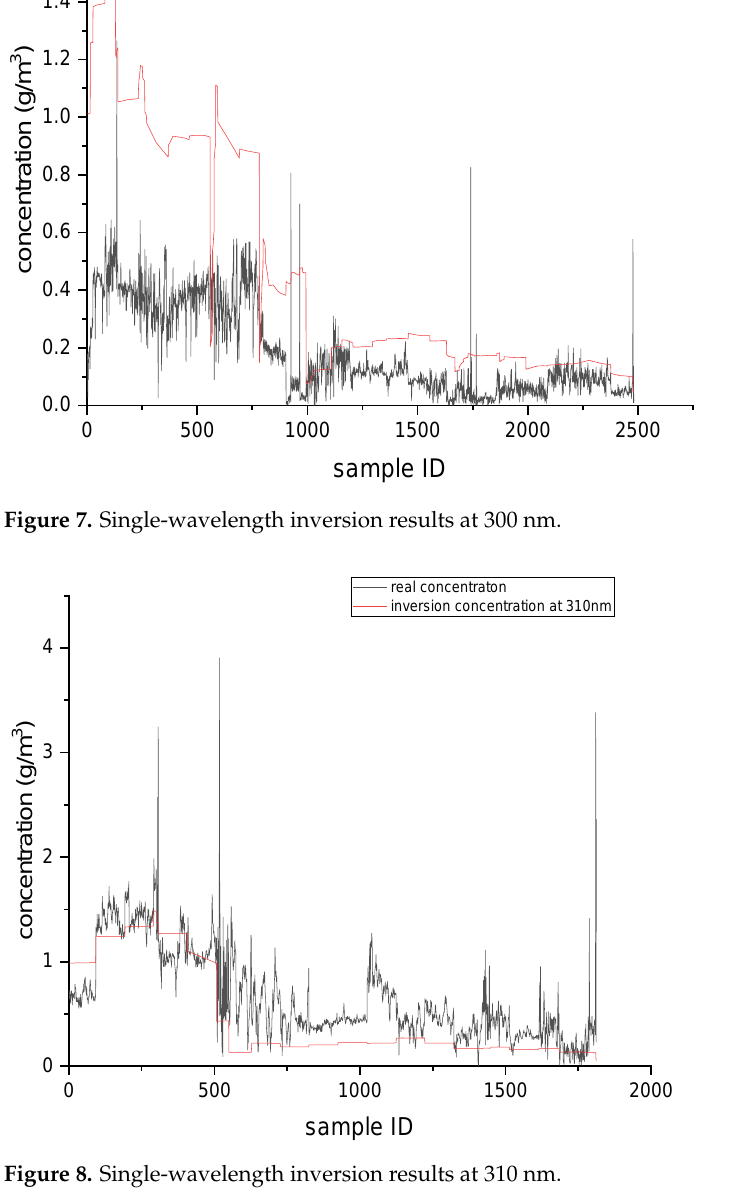
Figure 8. Single-wavelength inversion results at 310 nm. The errors in SO 2 concentration inversion using UV images at the three wavelengths are shown in Table 2. Table 2. SO 2 concentration inversion errors at three UV